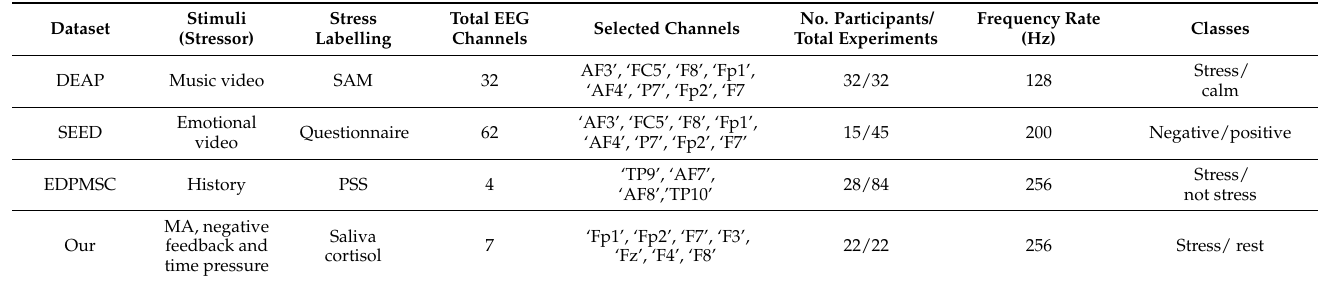
Table 1. A summary description of the datasets used in this